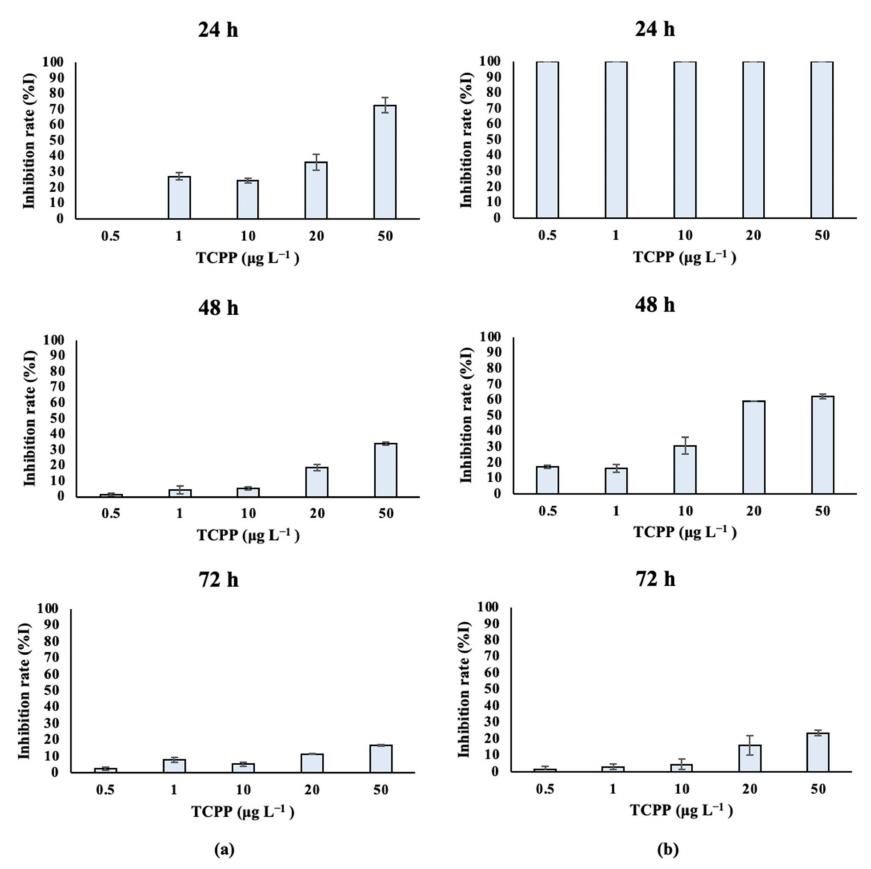
Figure 3. Inhibition of ( a ) Scenedesmus rubescens and ( b ) Chlorococcum sp. growth rate (%I) after exposure to TCPP for 24, 48 and 72